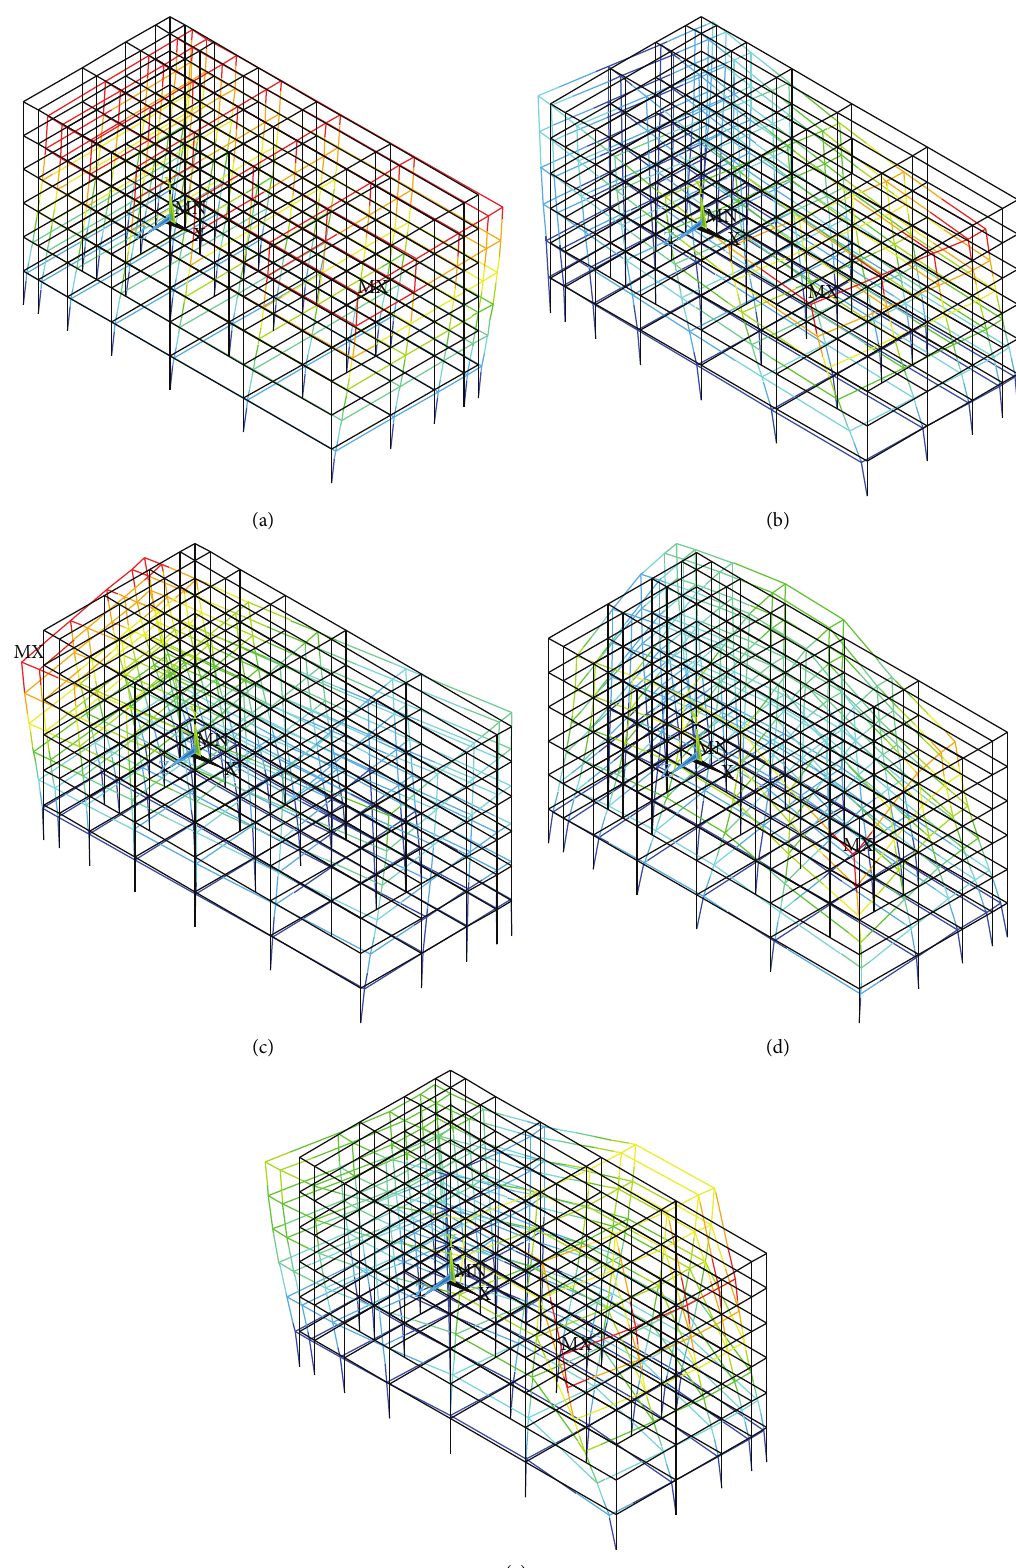
Figure 6: First 5 modes of building with the unsymmetrical distribution of columns model. (a) 1st mode (1.41 Hz). (b) 2nd mode (1.83Hz). (c) 3rd mode (2.07 Hz). (d) 4th mode (3.17 Hz). (e) 5th mode (3.81